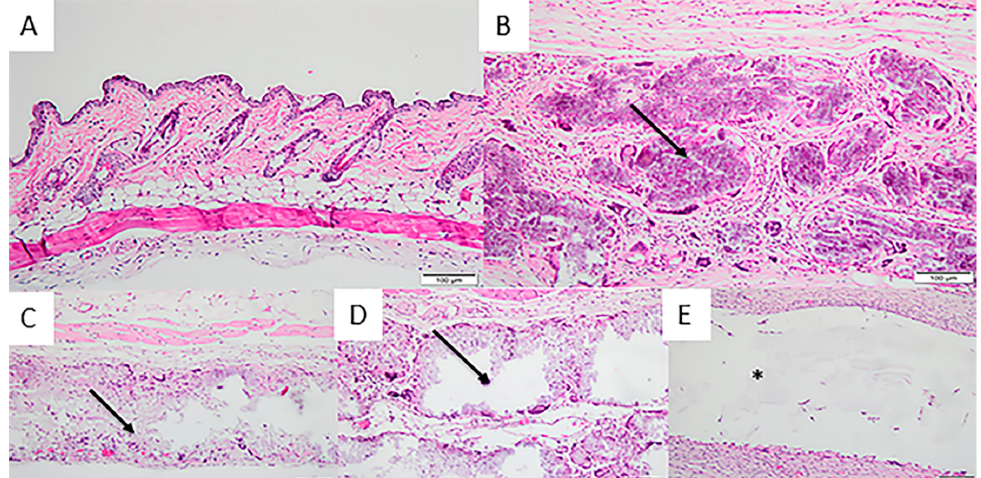
Figure 8. Photomicrographs of the experimental groups after 90 days of membrane implantation in the connective tissue. ( A ) Group 1 (Sham): discrete lymphocyte and macrophages infiltration and an absence of multinucleated giant cells and polymorphonuclear cells; ( B ) Group 2 (200 µm): moderate presence of macrophages, lymphocytes and multinucleated giant cells and a discrete presence of plasm cells; ( C ) Group 3 (500 µm) and ( D ) Group 4 (700 µm): presence of polymorphonuclear cells, plasmocytes and a moderate presence of lymphocytes, multinucleated giant cells and macrophages and ( E ) Group 5 (Pratix ® ): discrete presence of polymorphonuclear cells and a moderate presence of macrophages, multinucleated giant cells, lymphocytes and plasm cells. Arrow corresponds to the implanted membrane; Asterisk corresponds to the Pratix ® membrane site. (Magnification: 200×; Stain: Hematoxylin and Eosin).